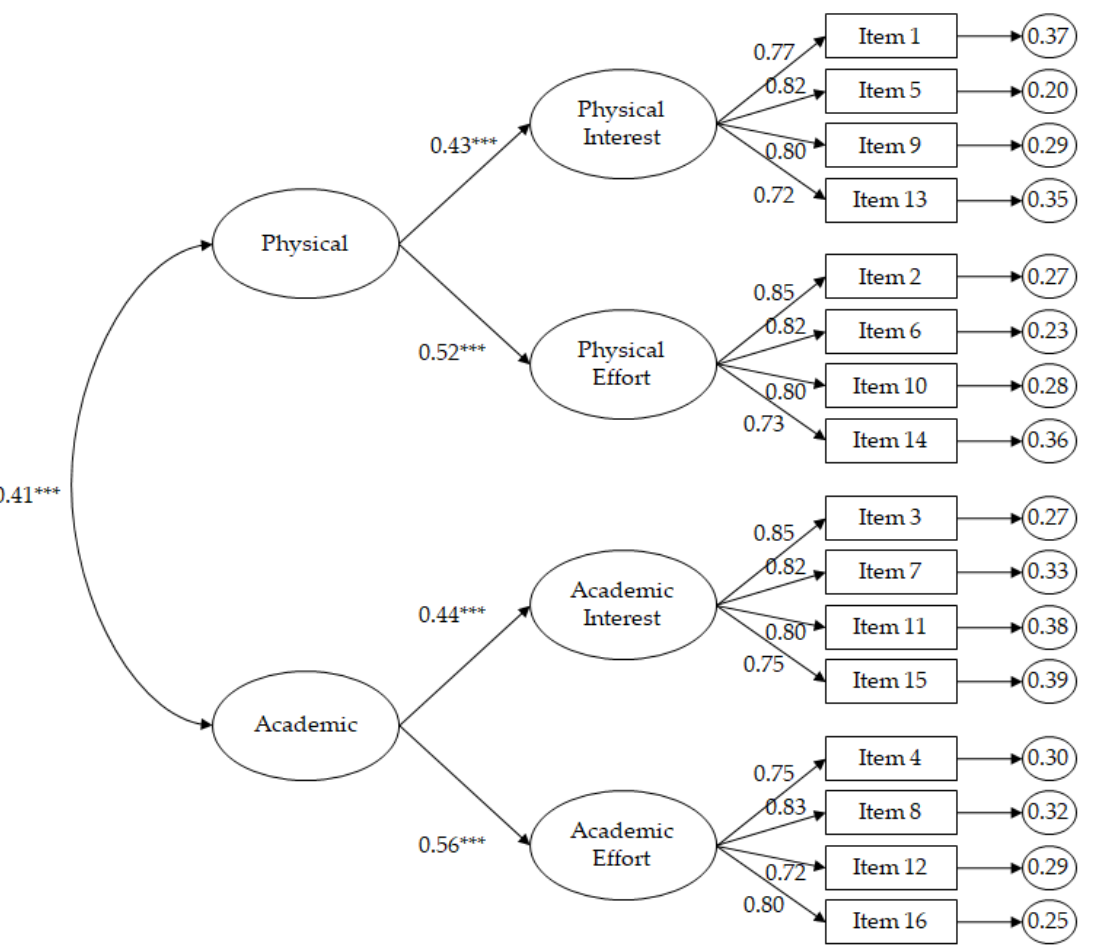
Figure 1. CFA of the PE-Grit focusing on the PE context. The ellipses represent the factors and the rectangles represent the different items. The residual variances are shown in the small circles. *** p < 0.001. Table 2. Comparison between the different models.